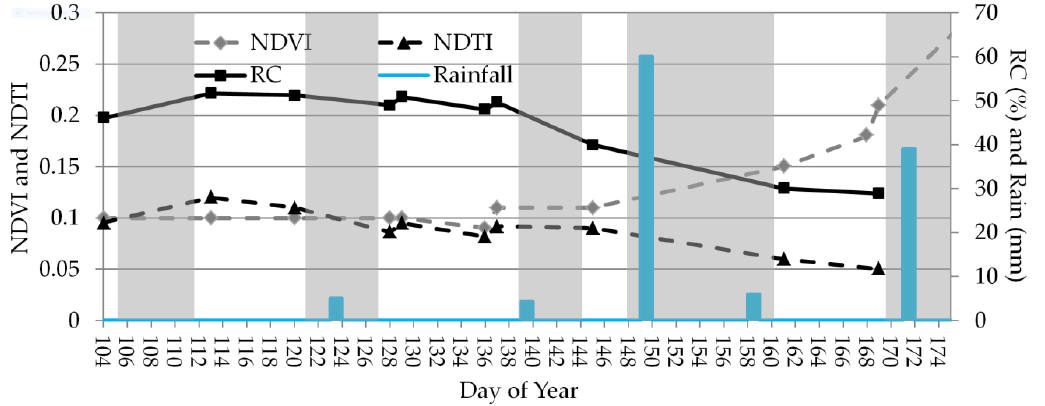
Figure 4. Synthetic representation of Normalized Difference Tillage Index (NDTI) (black dashed line) and Normalized Difference Vegetation Index (NDVI) (gray dashed line) over time and how it is masked and converted to residue cover (RC) (solid black line). The gray zones show where it is masked due to either clouds, high soil moisture (rainfall 2-day sum > 3mm, blue line), or NDVI > 0.3.